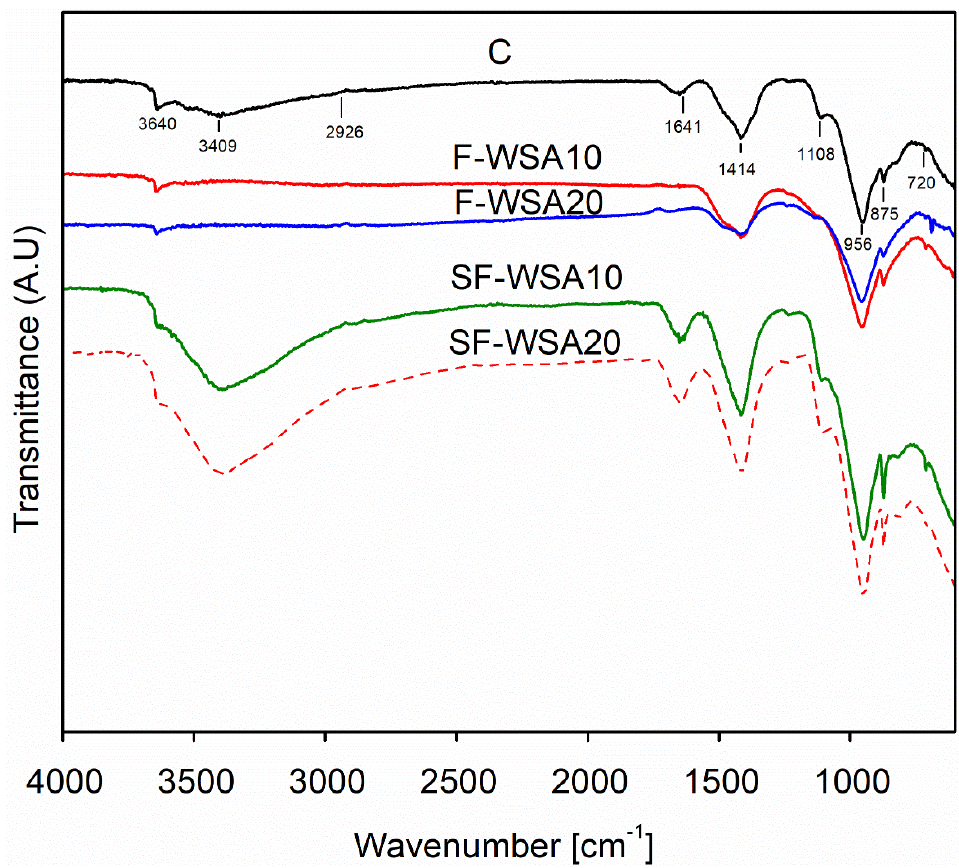
Figure 9. FTIR intensities for control concrete (CC) paste and pastes containing different percentages of fine and superfine WSA at 28 days.